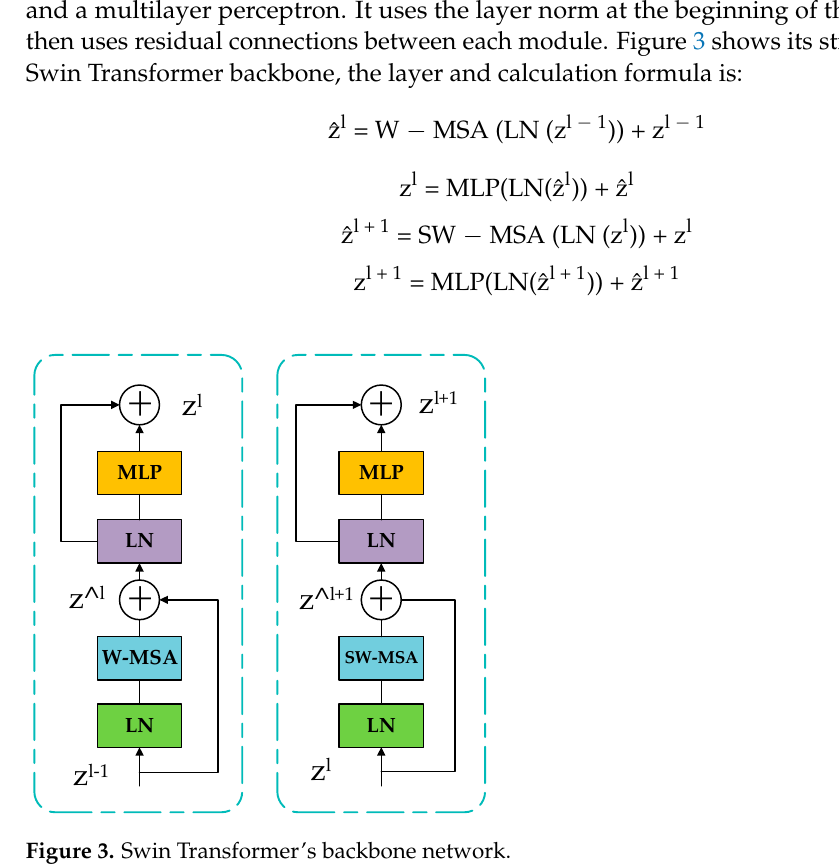
Figure 2. Swin Transformer network structure.